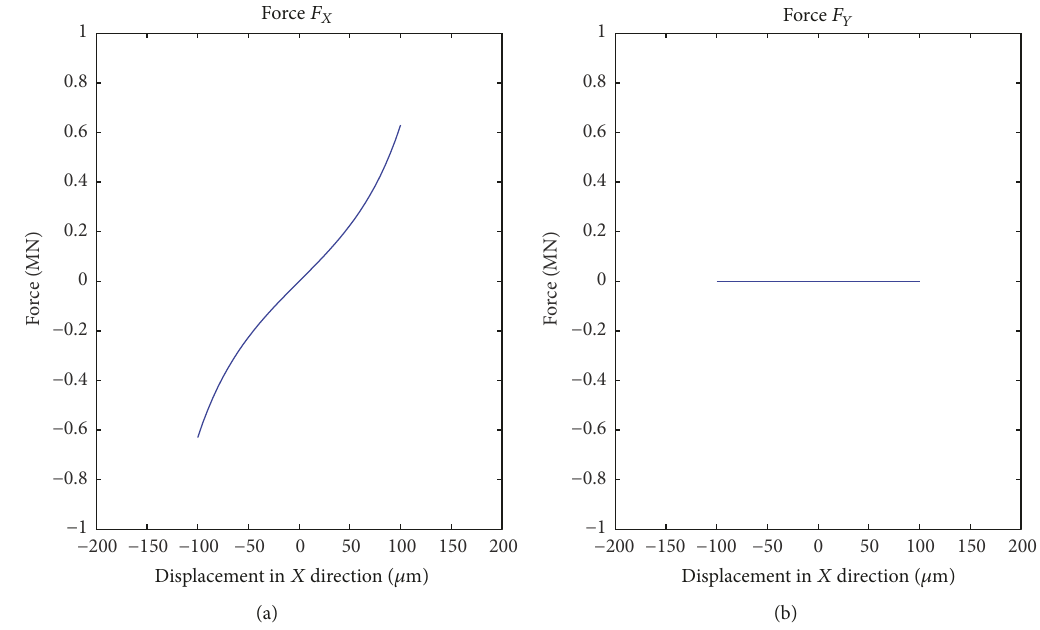
Figure 8: Upper journal bearing force components ( 𝐹 𝑋 and 𝐹 𝑌 ) versus shaft displacement 𝑋 for 𝜂 = 0.020 Pas and 𝑐 = 200 𝜇 m.